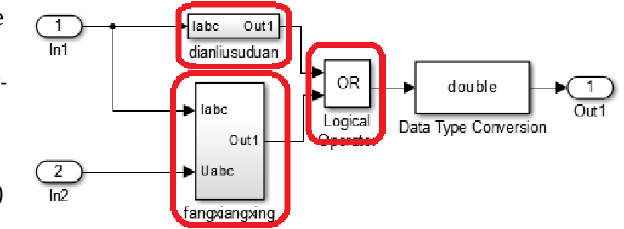
Figure 4: Model of directional current protection module